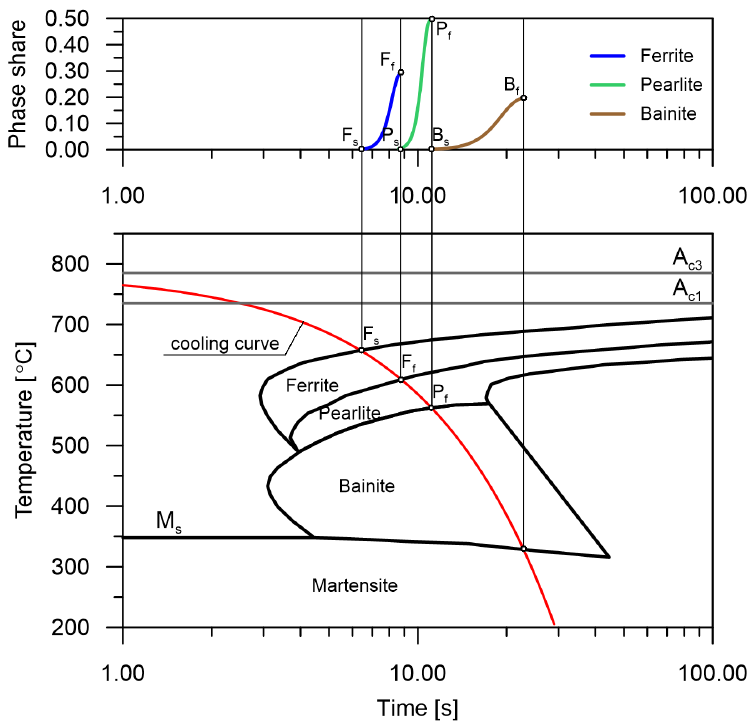
Figure 2. The determination of ranges of phase transformations from the CCT